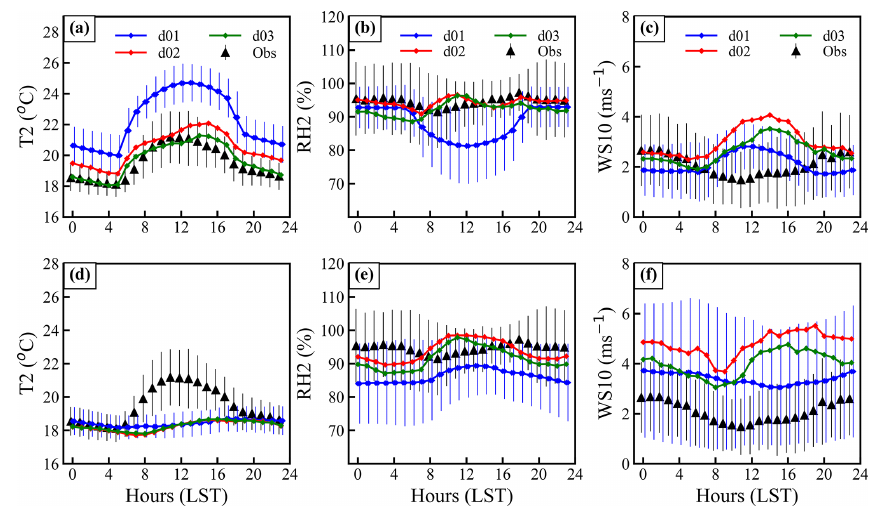
Figure 6. Mean diurnal variations of (a) 2m temperature ( T 2), (b) 2m relative humidity (RH2), and (c) 10m wind speed (WS10) from model simulations (d01, d02, and d03) and observations. Altitude-adjusted variations are also shown (d–f) . The bars represent the standard deviation and are shown only for domain d01 and the observations in order to avoid